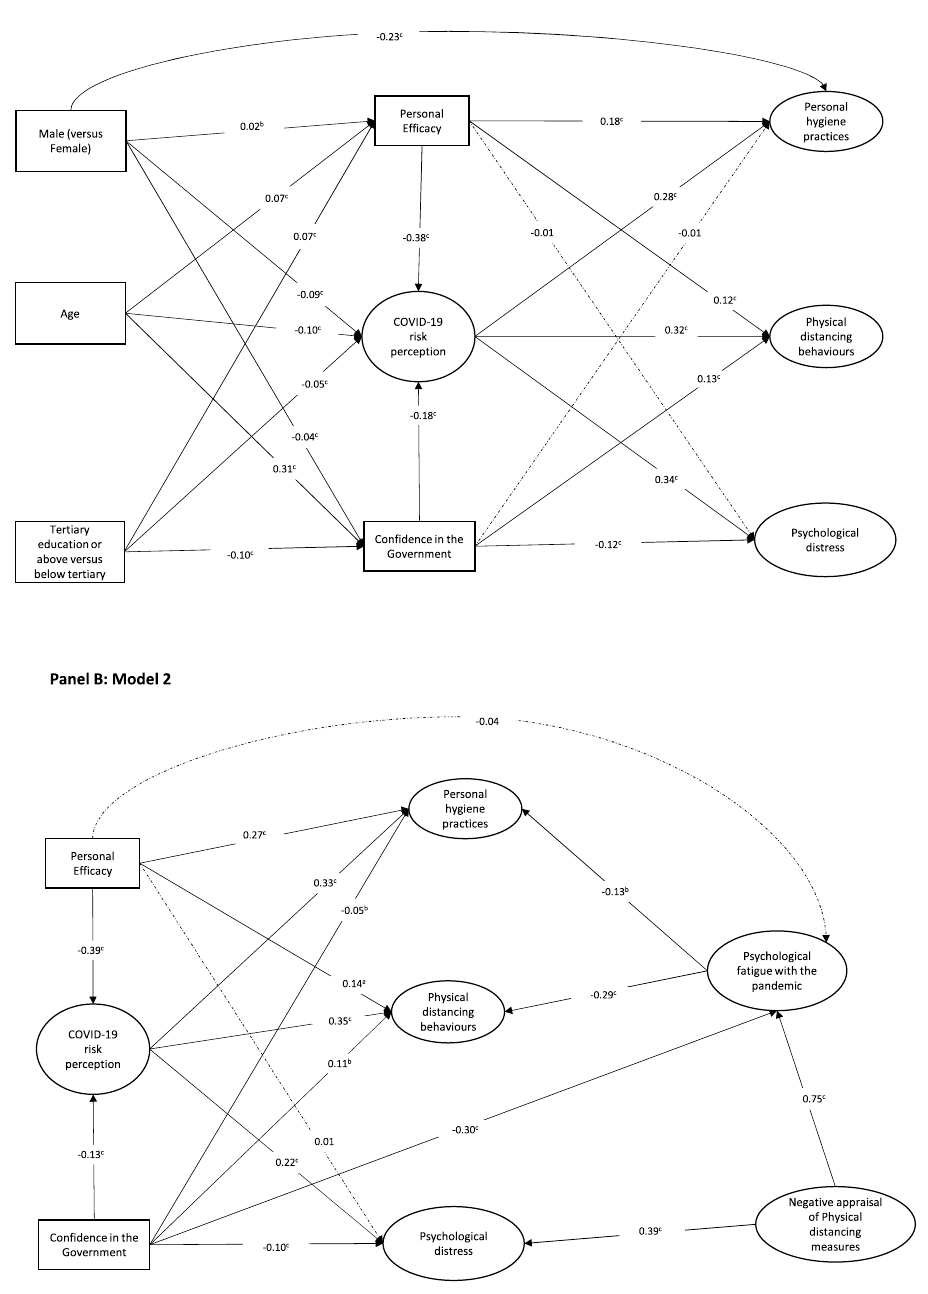
Figure 4. Associations among stress appraisal, precautionary behaviours and psychological distress and their associated factors based on structural equation modelling (SEM). Variables in Oval shape were treated as latent variables while variables in rectangles were treated as observed variables in SEM. All numbers on the line arrows were standardized path coefficients. Dotted lines indicate that the path coefficients were not statistically significant. a p < 0.05; b p < 0.01; c p <